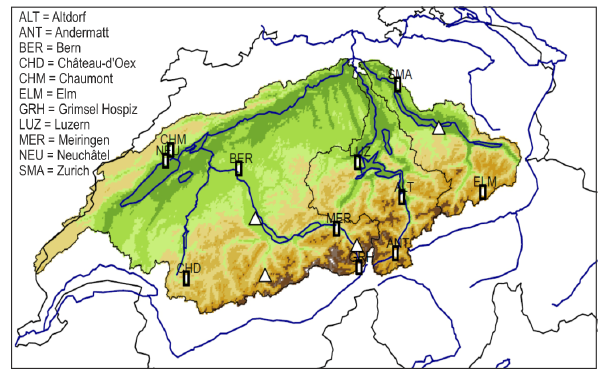
Figure 1. Catchment of the Aare River. All data used in this study represent averages over this region. The representative weather sta- tions are shown as squares (providing both temperature and precip- itation) and triangles (only